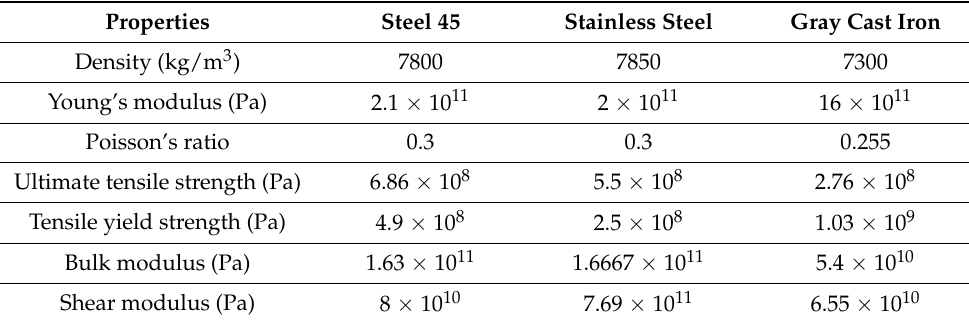
Figure 3. CAD model: ( 1 ) bearing type 20213kTVC3; ( 2 ) bearing housing; ( 3 ) bracket. Table 1. Material